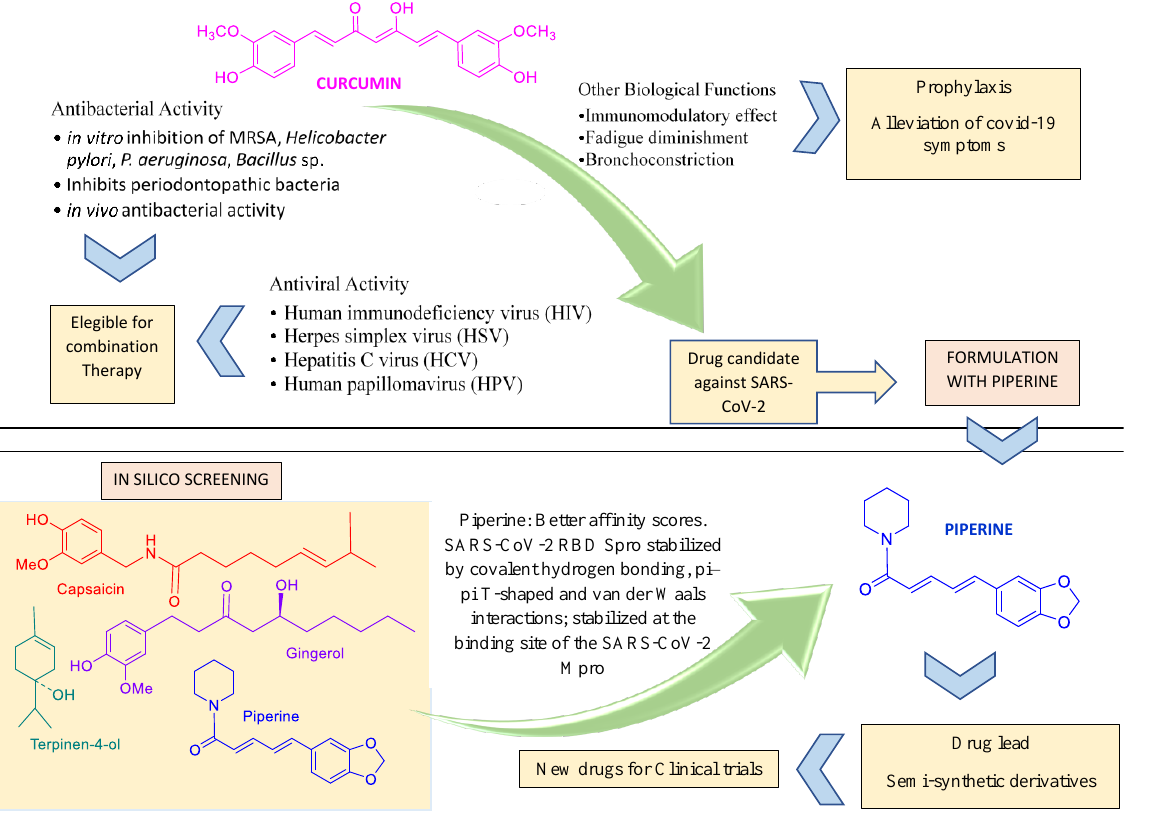
Figure 4. Curcumin and piperine features compatible with their use in combined pharmacotheraphy. Allicin [95,96], eugenol [97,98], thymoquinone [99], apigenin [100,101], carvacrol